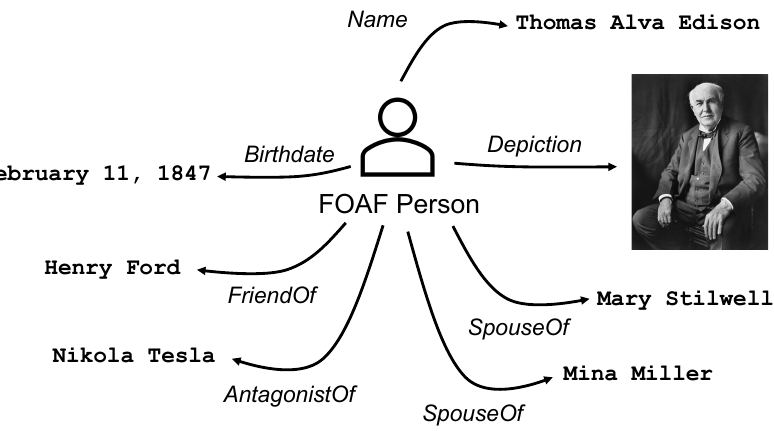
Figure 2. This example shows how to use semantic data and the Friend of a Friend (FOAF) ontology to describe people and their relationships. Image of Thomas Edison from the Library of Congress, copyright by Bachrach (circa